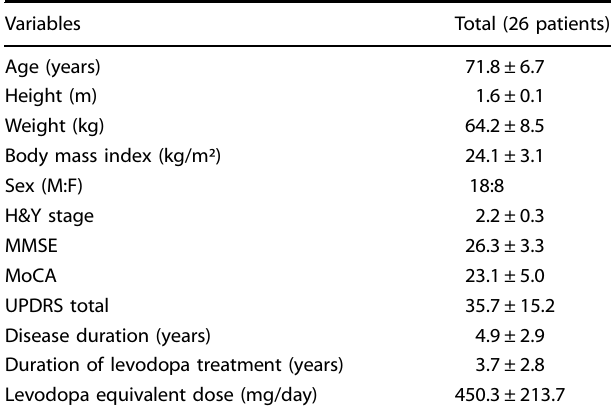
Table 4. Demographic data of the included